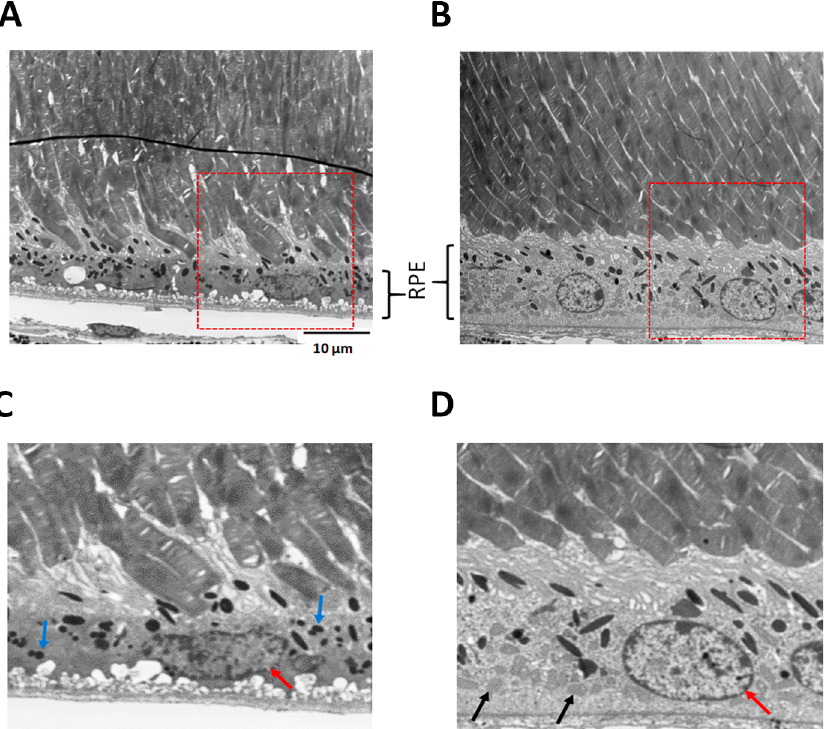
Fig 7. Improved ultrastructure of RPE. Ultrastructure analysis showed preservation of photoreceptors and RPE in the zeaxanthin treated eyes (n = 2) (B and D), whereas the eye from untreated mice (n = 2) (A and C) revealed broken tips of photoreceptors outer segments. Mitochondria were visible in the treated RPE (black arrows in D) but were sparse in the untreated eyes. The accumulation of lipofuscin granules (small black dots indicated by blue arrows in C) were reduced in treated eyes. RPE of the untreated eye had visible nuclear alterations such as nuclear pyknosis whereas the RPE cells in treated eyes had a normal, round nucleus (red arrow).